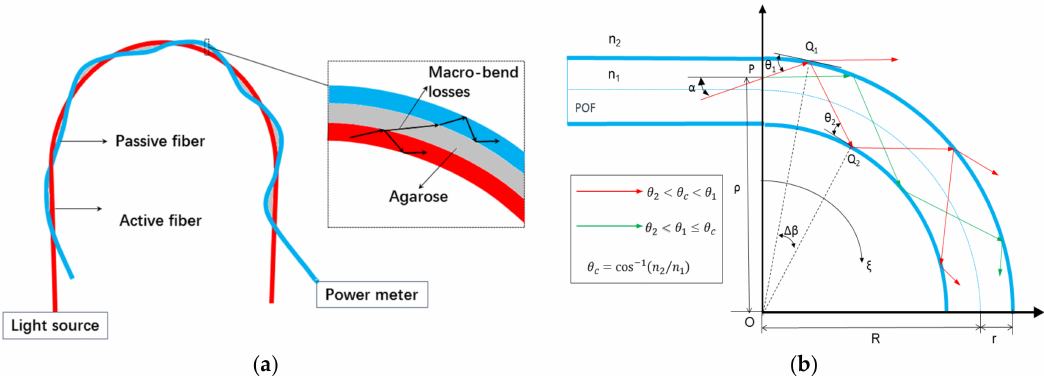
Figure 1. ( a ) Schematic diagram of the proposed RH sensor; ( b ) Geometrical model of the macro-bend active